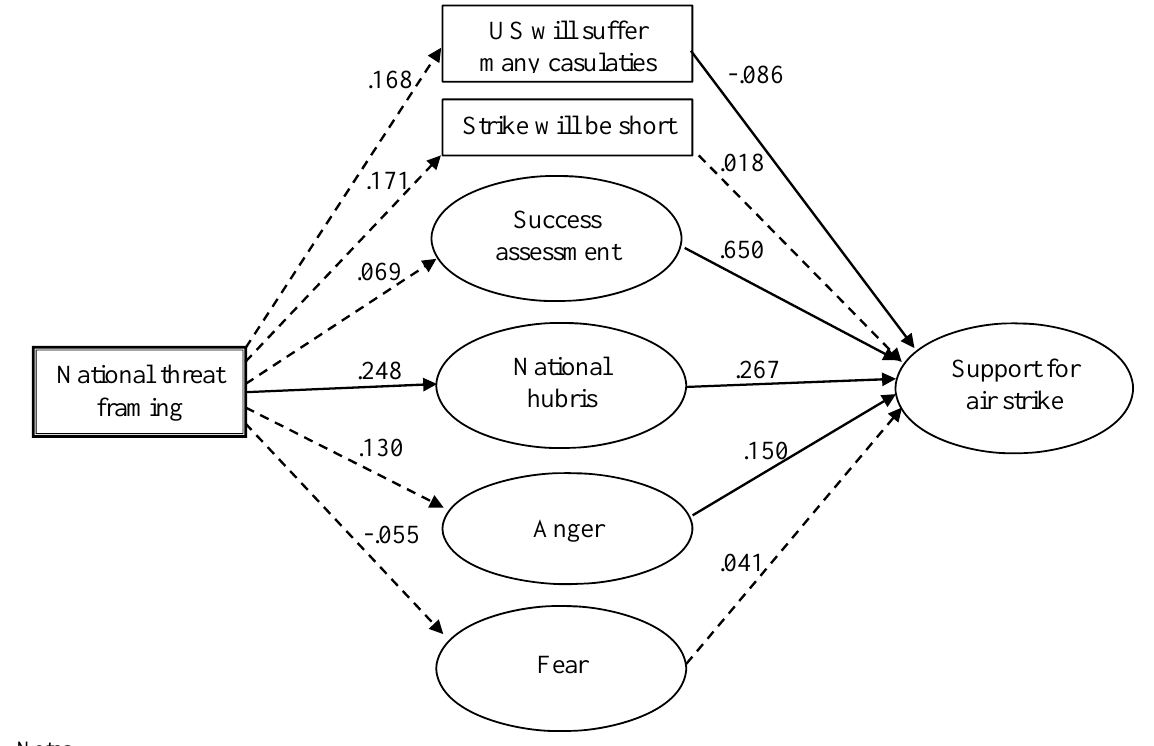
Figure 6: Author’s argument versus competing